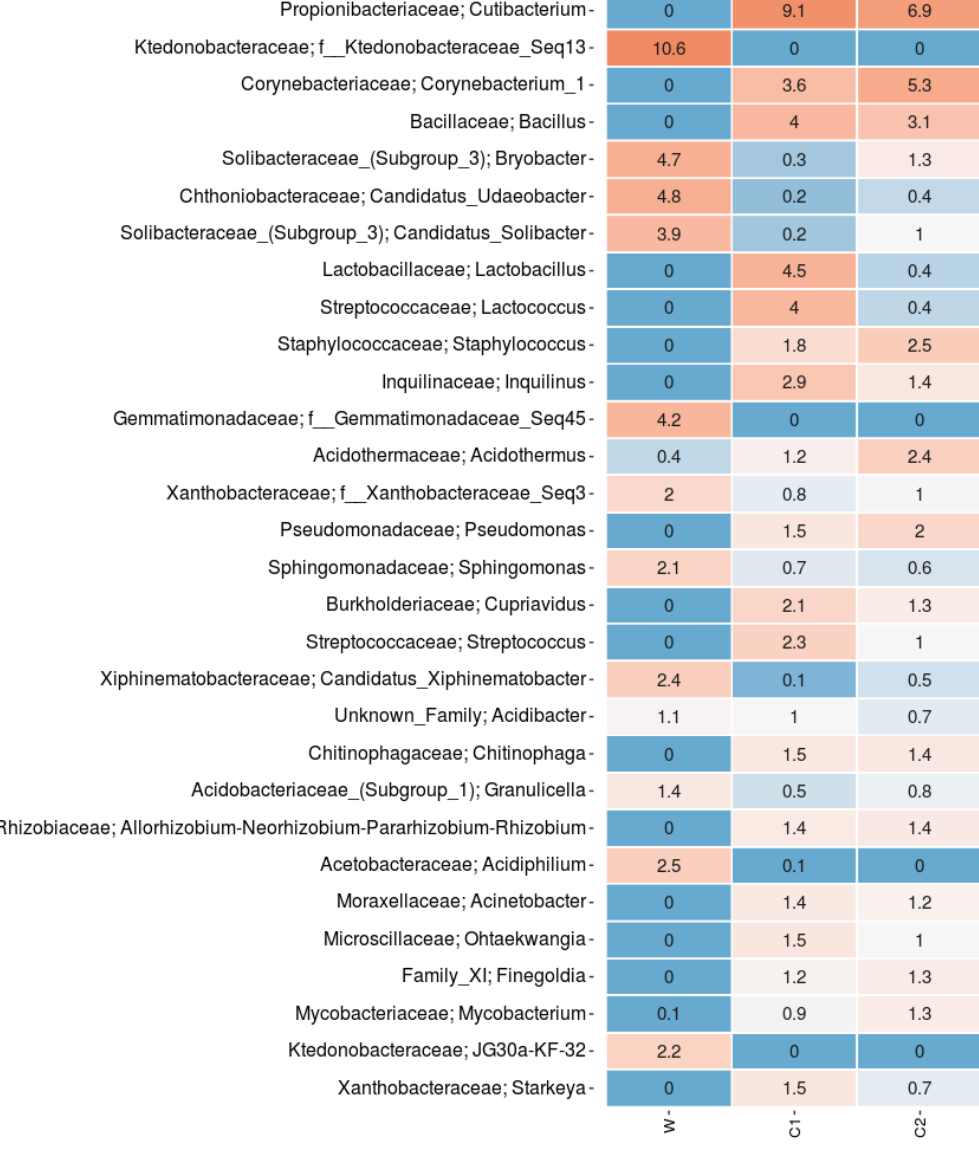
Figure 10: Heatmap of the 30 most abundant phylotypes for 3 horizons of N18 soil